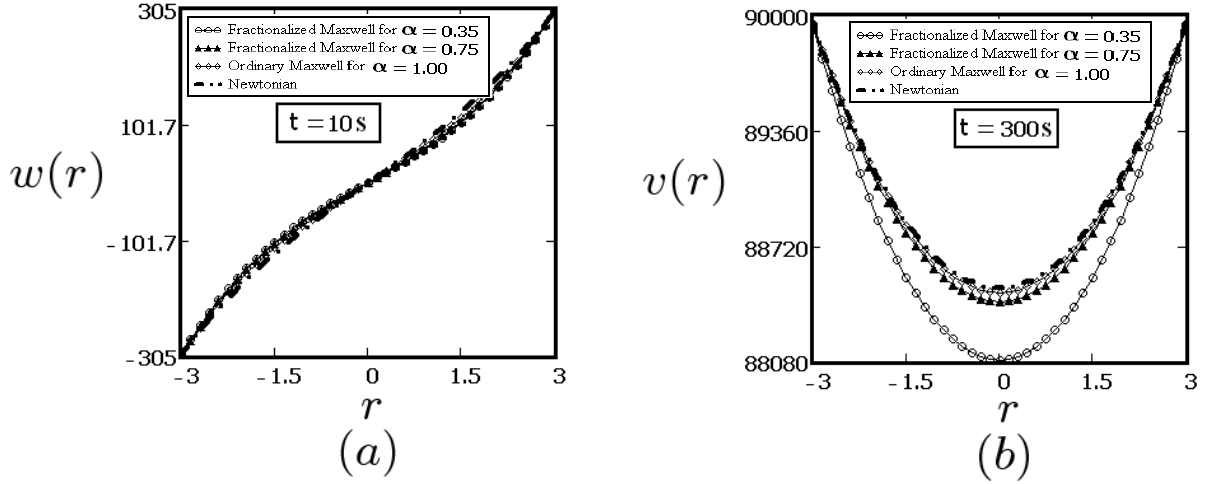
Fig. 9: Profiles of the velocity components w ( r , t ) and v ( r , t ) given by Eqs. (32), (33),(42), (43), (46) and (47) for fractionalized Maxwell, or- dinary Maxwell and Newtonian fluids, for R = 3, Ω = 1, U = 1, ν = 0.9292, µ = 26, λ = 5, α = 0.35, &0.75, p = 2 and for large time t